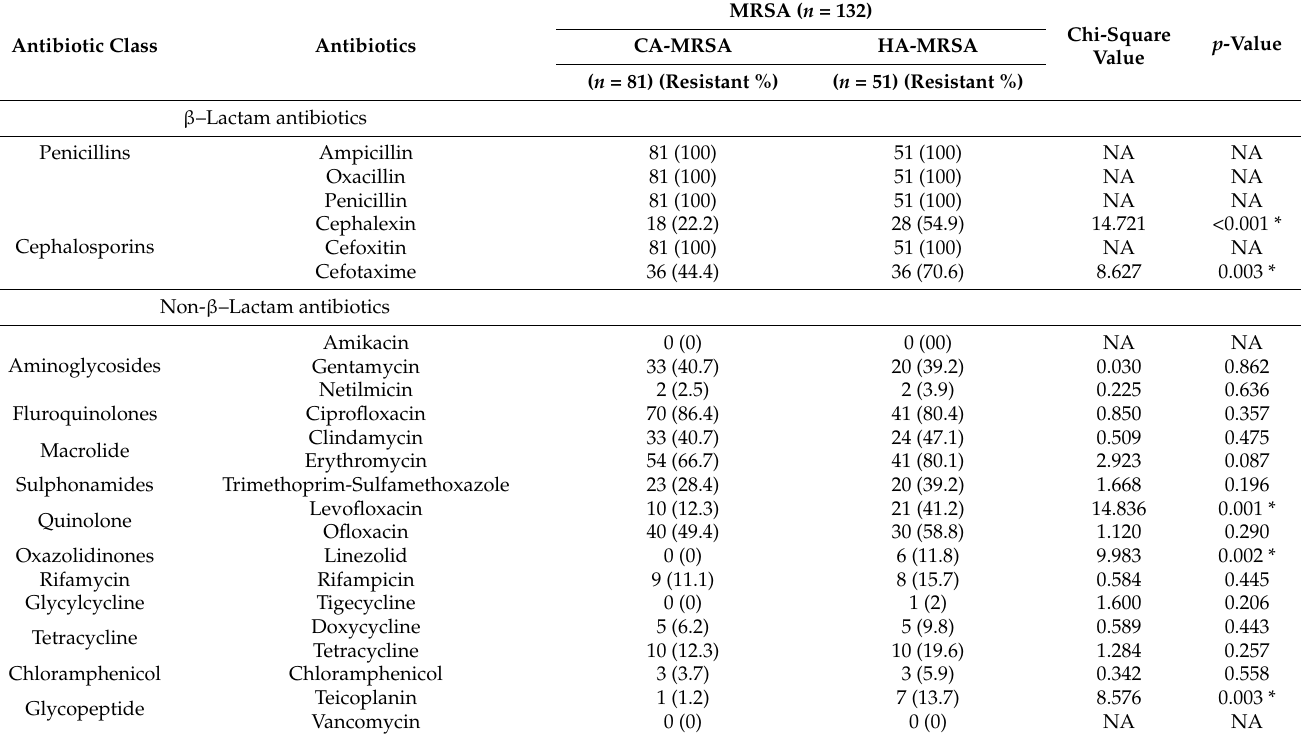
Table 2. Antibiotic resistance profiles of